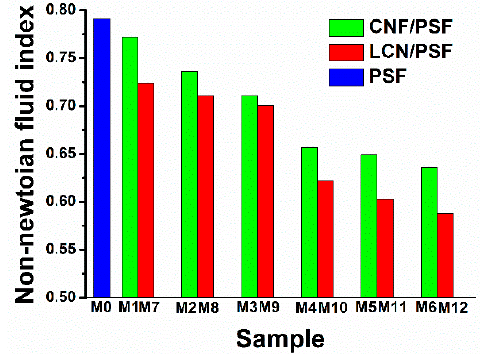
Figure 10. Non-Newtonian fluid index of membrane solutions: Sample M0–12.